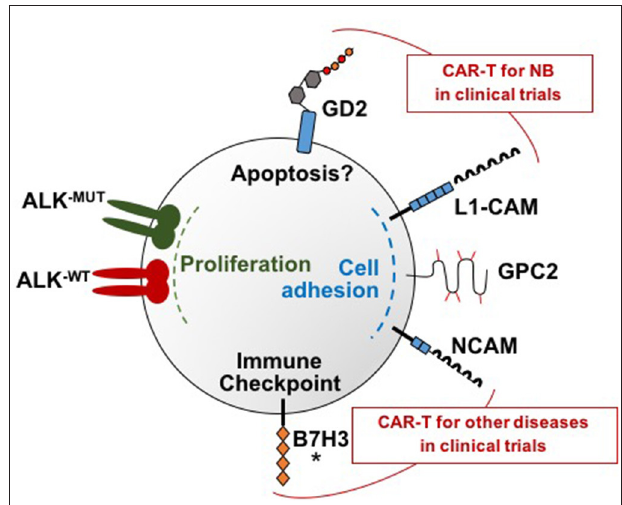
FIGURE 1 | Molecular targets under investigation for CAR T cell therapy for neuroblastoma. There are a total of six neuroblastoma surface targets for which CAR T cells have been developed: GD2, L1-CAM, GPC2, B7H3, and ALK, and NCAM. These targets each have distinct functions that are depicted in this figure. Note that both wild type and mutated ALK are overexpressed on neuroblastoma samples and both can be targeted by the ALK CARs. GD2 and L1-CAM are the two targets currently in clinical trials for neuroblastoma. Clinical trials that include CAR T cells targeting NCAM are ongoing for multiple myeloma and AML but not yet for neuroblastoma. An asterisk marks B7H3 because clinical trials are currently being